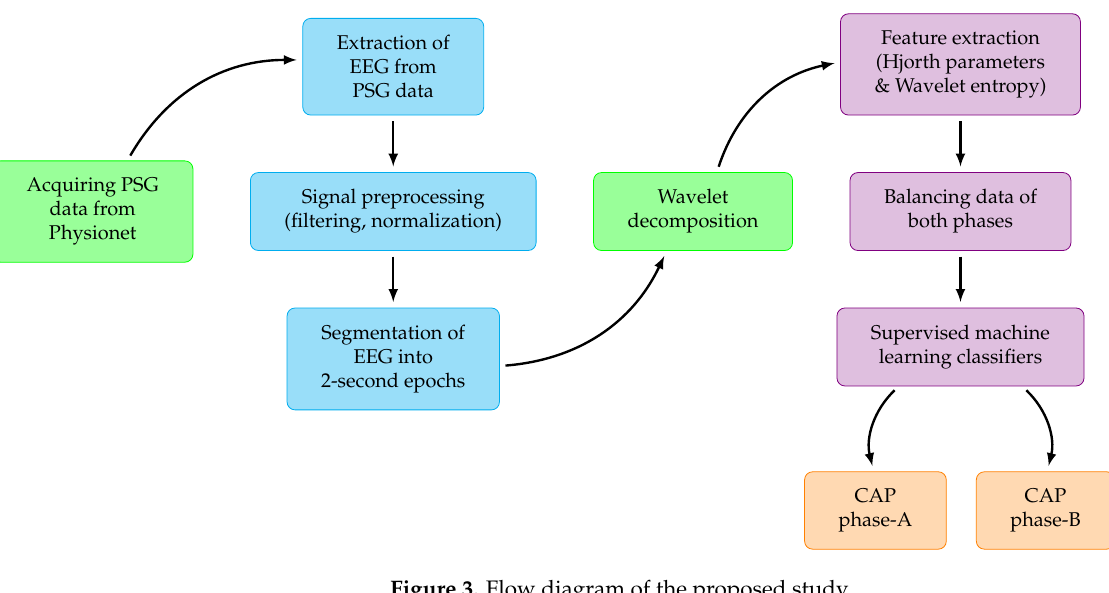
Figure 3. Flow diagram of the proposed